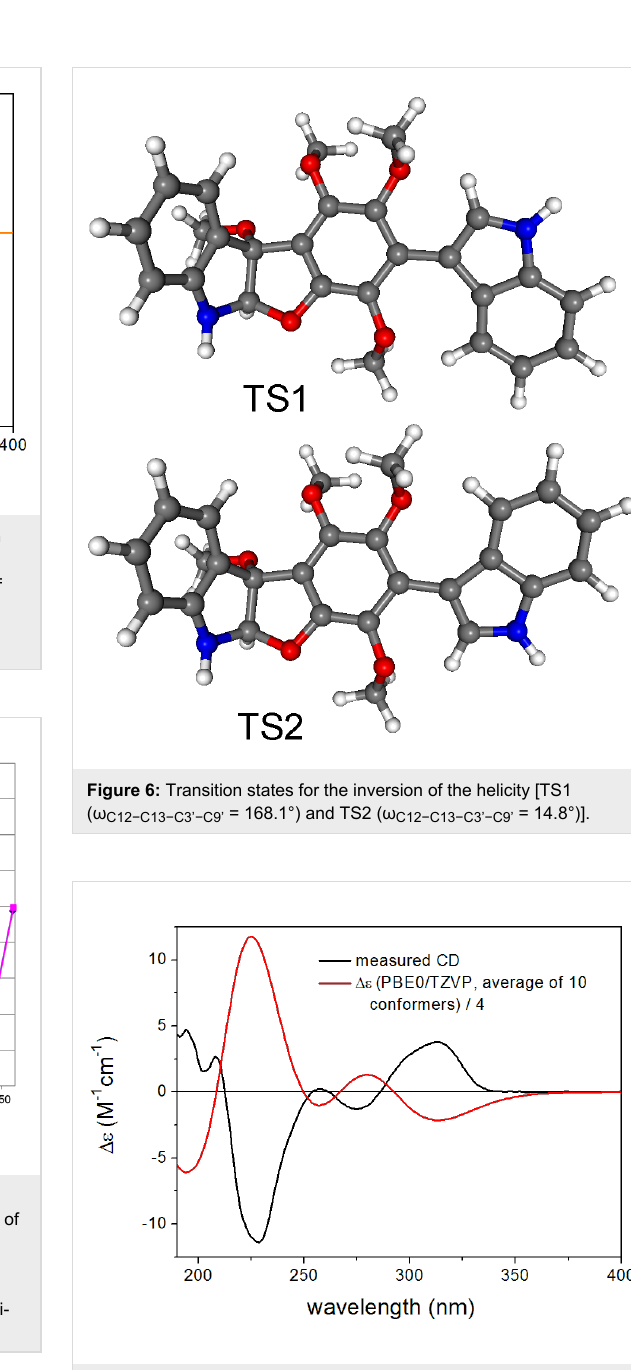
Figure 7: Experimental ECD spectrum of 1 in MeCN compared with the Boltzmann-weighted PBE0/TZVP ECD spectrum of (2 R ,3 R )- 1 computed for the B3LYP/6-31G(d)